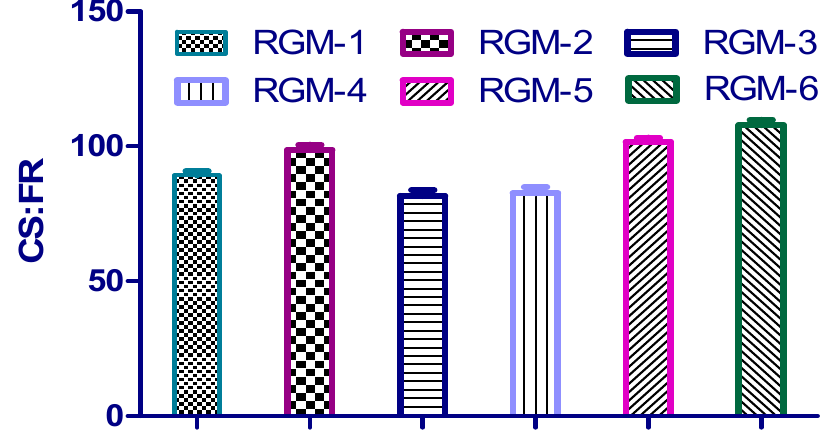
Figure 5. Assessment of the crushing strength friability ratio (CSFR) for prepared batches.